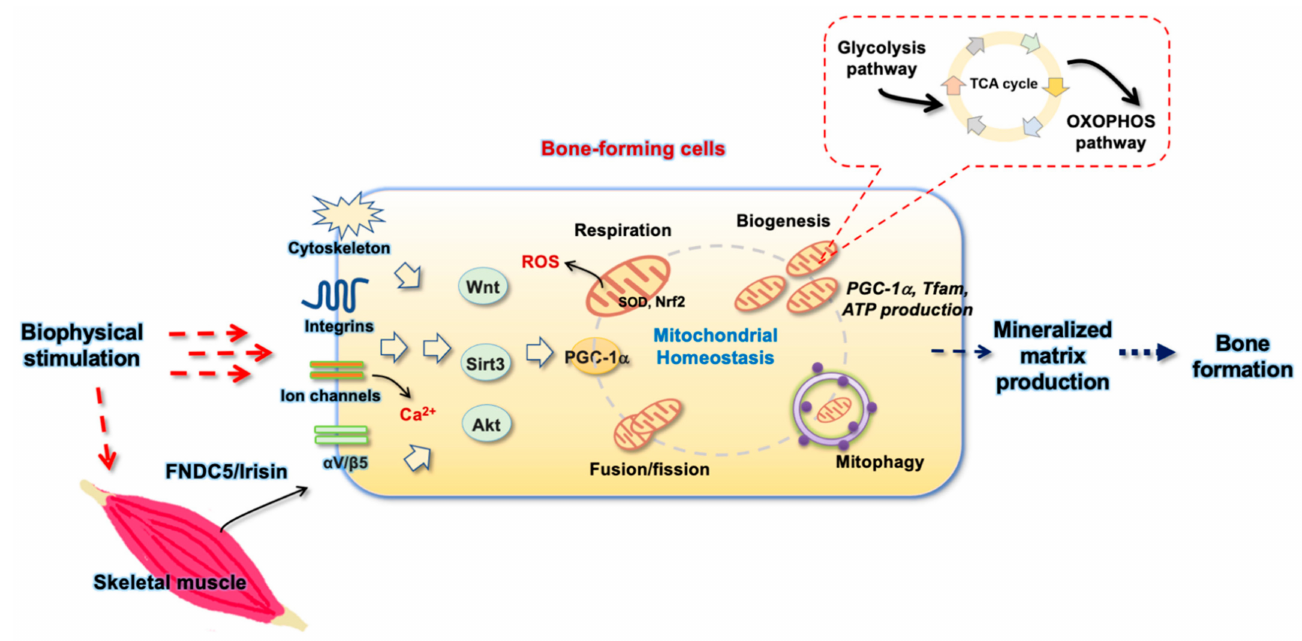
Figure 2. Schematic diagram showing the biophysical stimulation-induced modulation of mechanosensitive molecules- mediated mitochondrial homeostasis involved in bone forming cell anabolism and bone